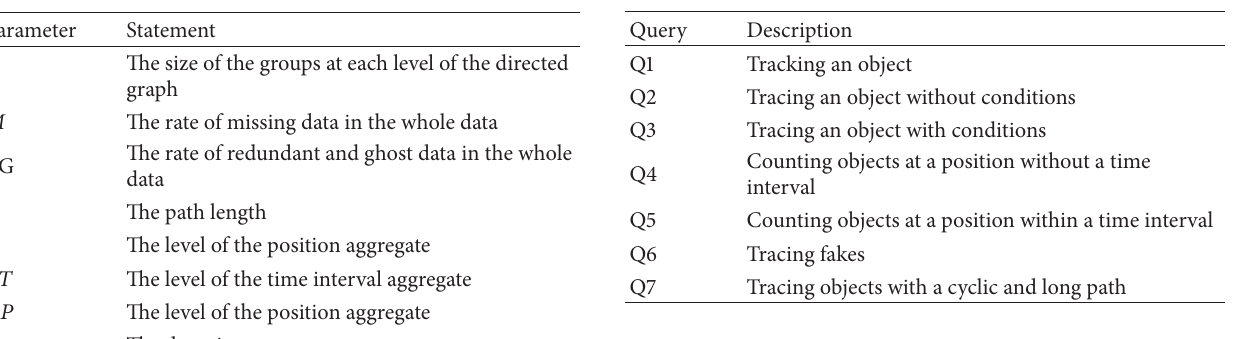
Table 5: Experimental parameters. Table 6: Test